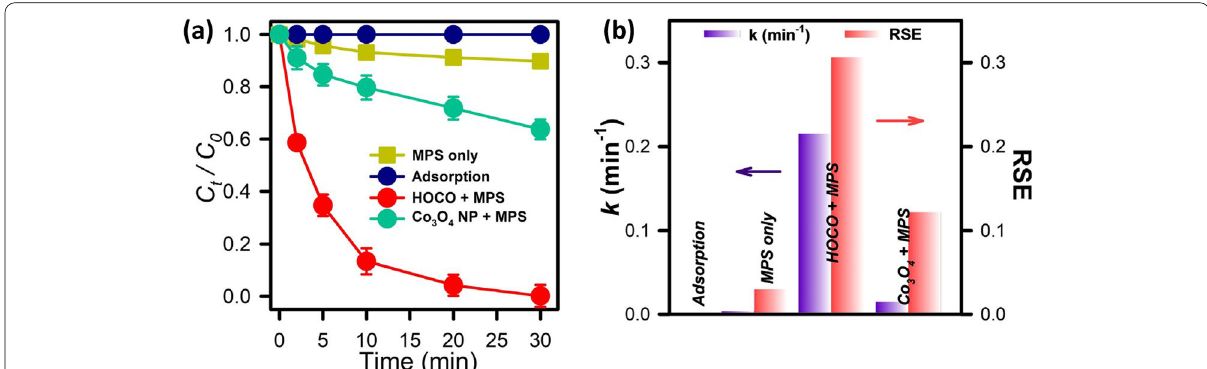
Fig. 4 ( a ) ARS elimination by various catalytic systems: MPS only, adsorption, Co 3 O 4 NP degradation kinetics ( k ) (min − 1 ) and reaction stoichiometric efficiency (RSE) values of different catalytic systems on ARS degradation (Reaction conditions: catalyst MPS:100 mg L − 1 , T 30 = =